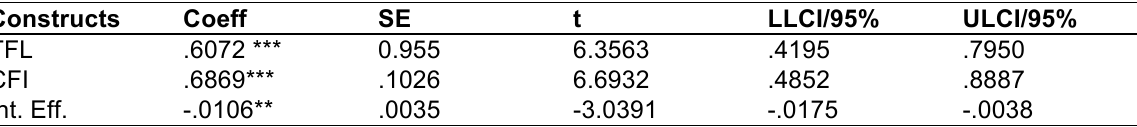
Table 6: Model summary outcomes/managerial innovation behavior